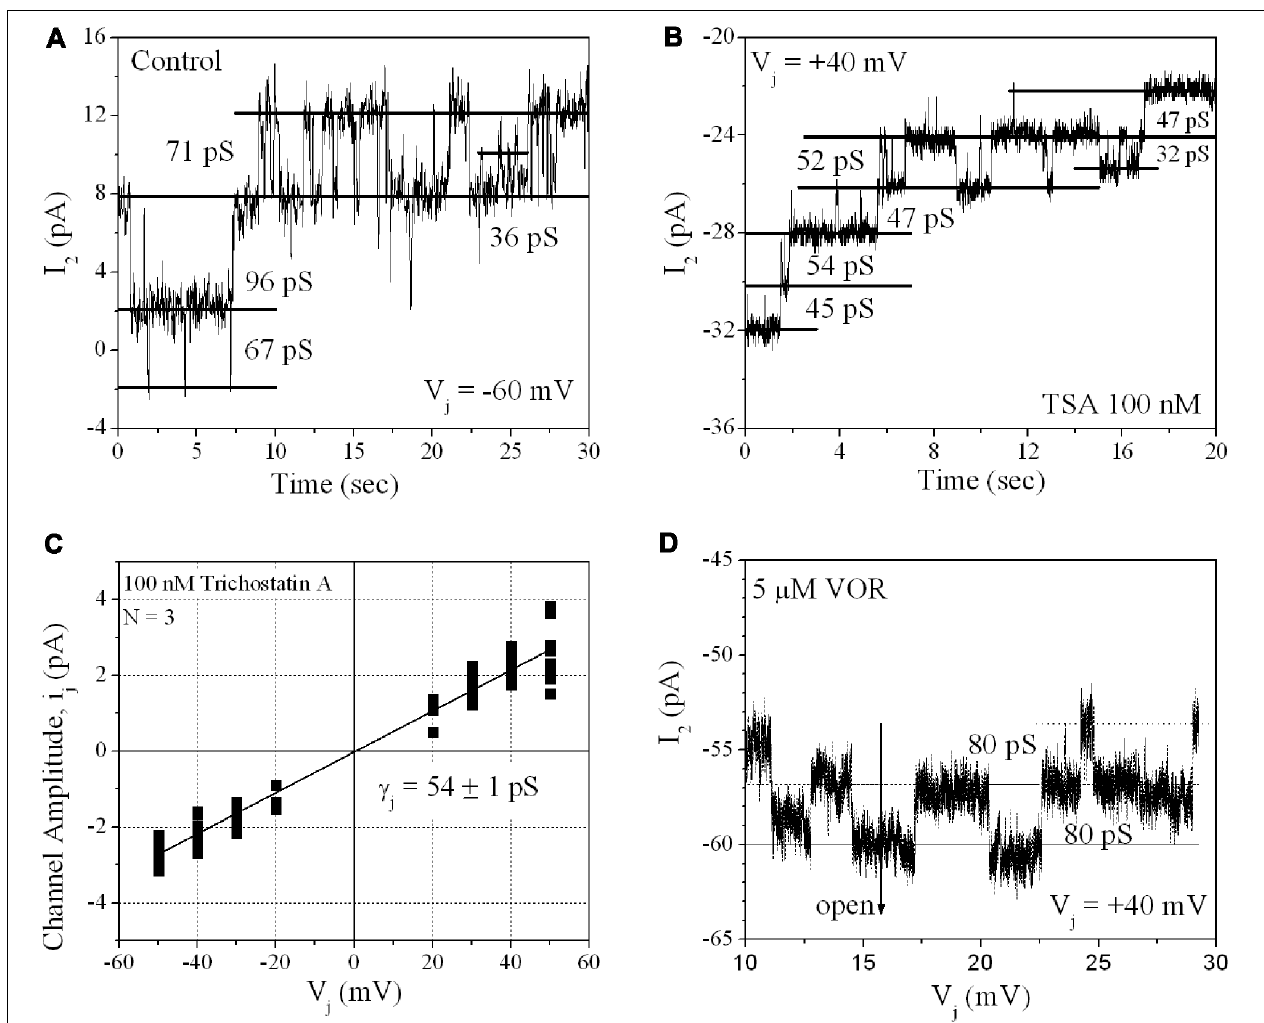
FIGURE 8 | Single gap junction channel conductance ( γ j ) of HDACI-treated ventricular myocytes. (A) A representative example of single channel open–closed events during an I j recording in response to a + 60 mV, 30 s V j pulse applied to a pair of primary cultured ventricular myocytes. Note the activity of low (30–50 pS), intermediate (60–80 pS), and high (90–110 pS) γ j states typical of Cx43 GJ channel activity. (B) An example of GJ channel activity recorded from a pair of ventricular myocytes treated with 100 nMTSA during a − 40 mV, 30 s V j pulse. Only low (30–50 pS) γ j channel activity was observed in this experiment. (C) Single gap junction